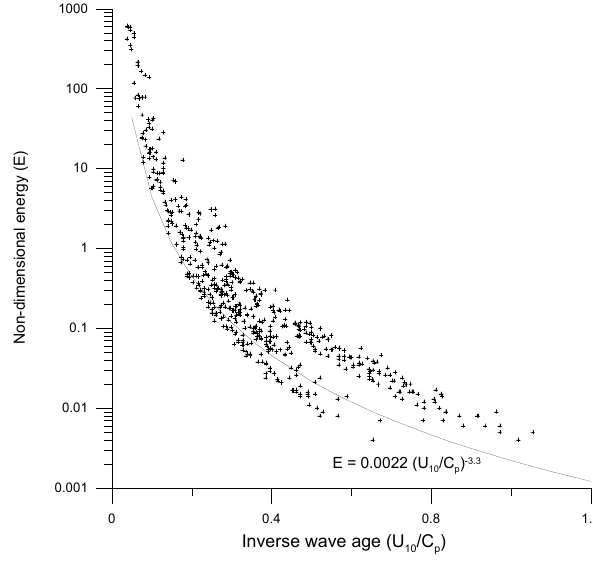
Fig. 6. Variation of non-dimensional energy with inverse wave Figure 6. Variation of non-dimensional energy with inverse wave age